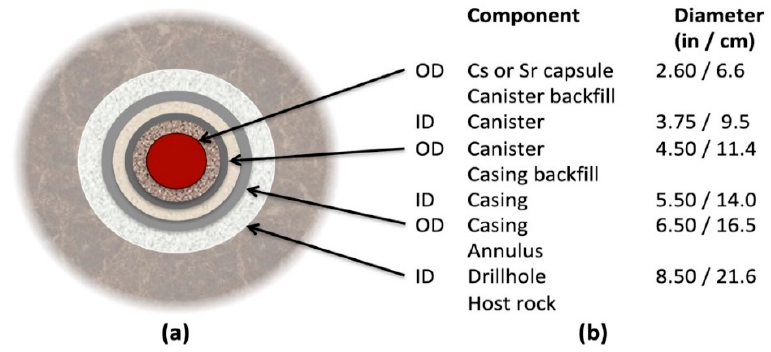
Figure 2. ( a ) Cross-sectional schematic of components in a horizontal drillhole used for the disposal of heat-generating cesium or strontium capsules; and ( b ) list of inner diameters (ID) and outer diameters (OD) of the components [27].